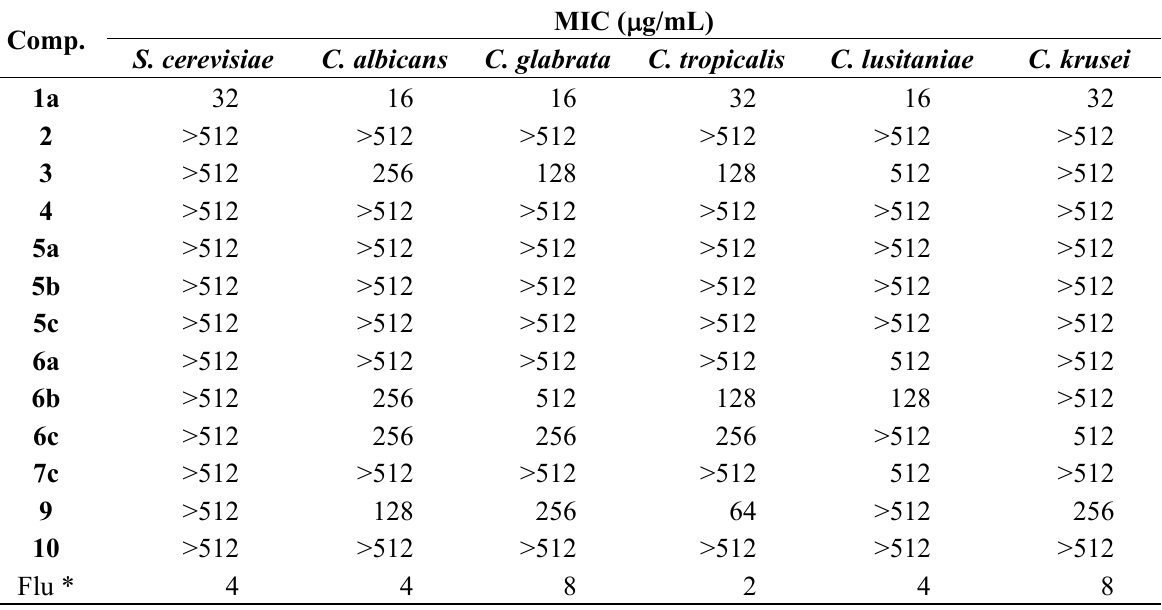
Table 1. Antifungal in vitro activity of compounds 1 – 10 . Comp.